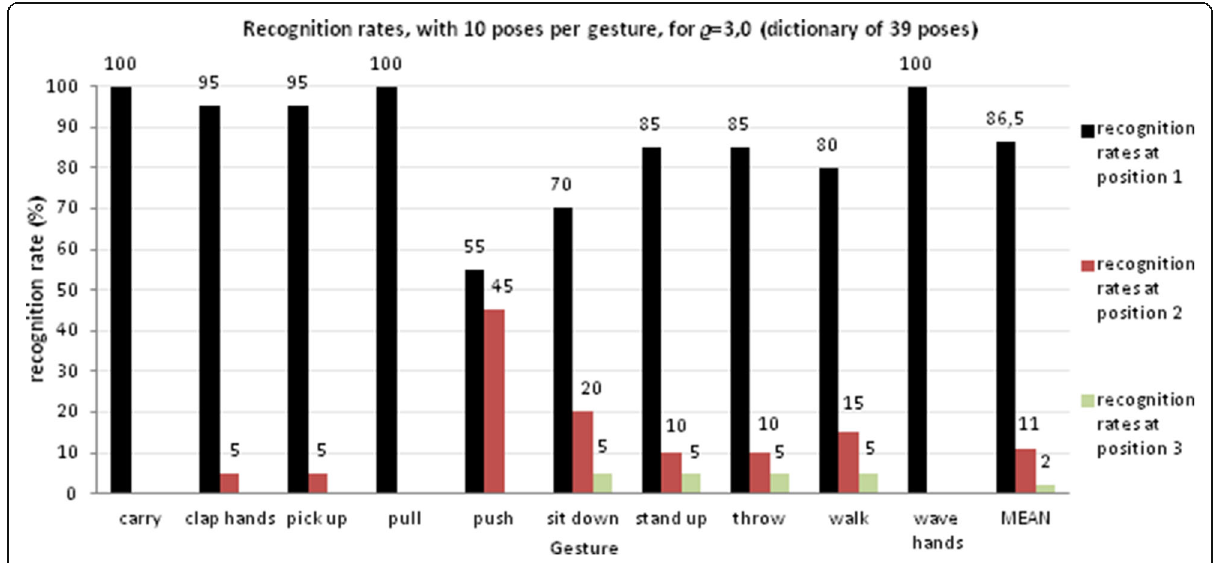
Fig. 9 Recognition rates per gesture for UTKinect Human Detection